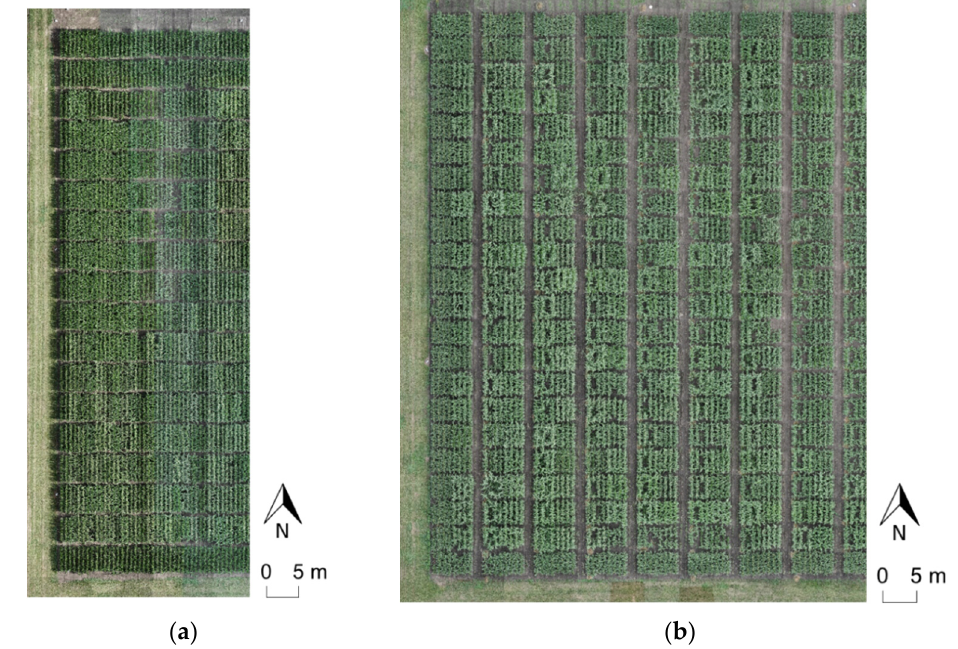
Figure 6. Orthophotos of the ( a ) maize and ( b ) sorghum fields used for the dataset acquisition for the experimental results.